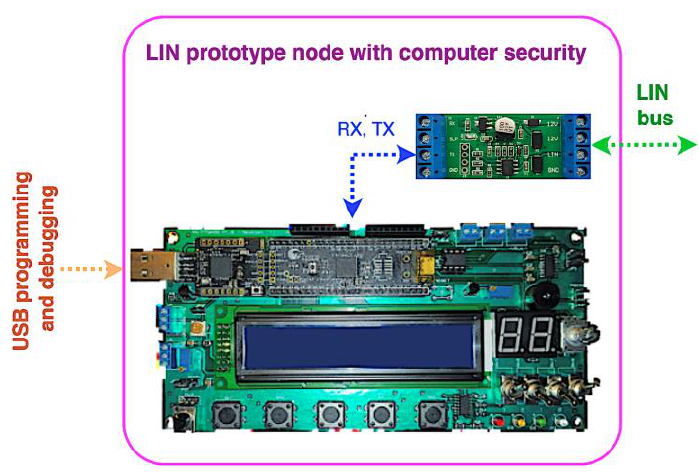
Figure 11. Prototype LIN node structure for network testing.